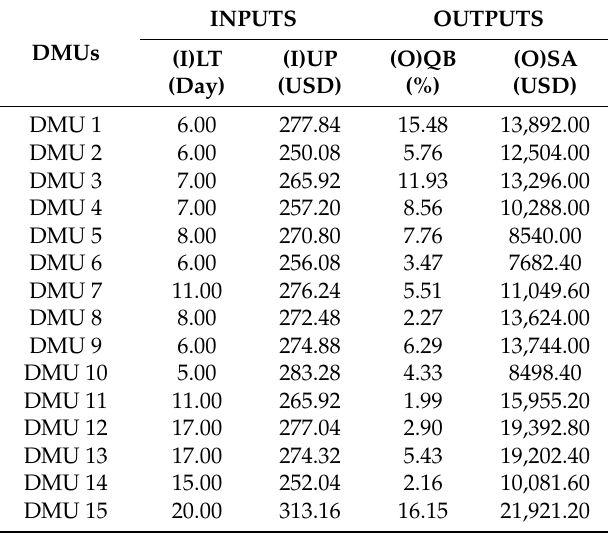
Table 13. Raw date of DEA model.